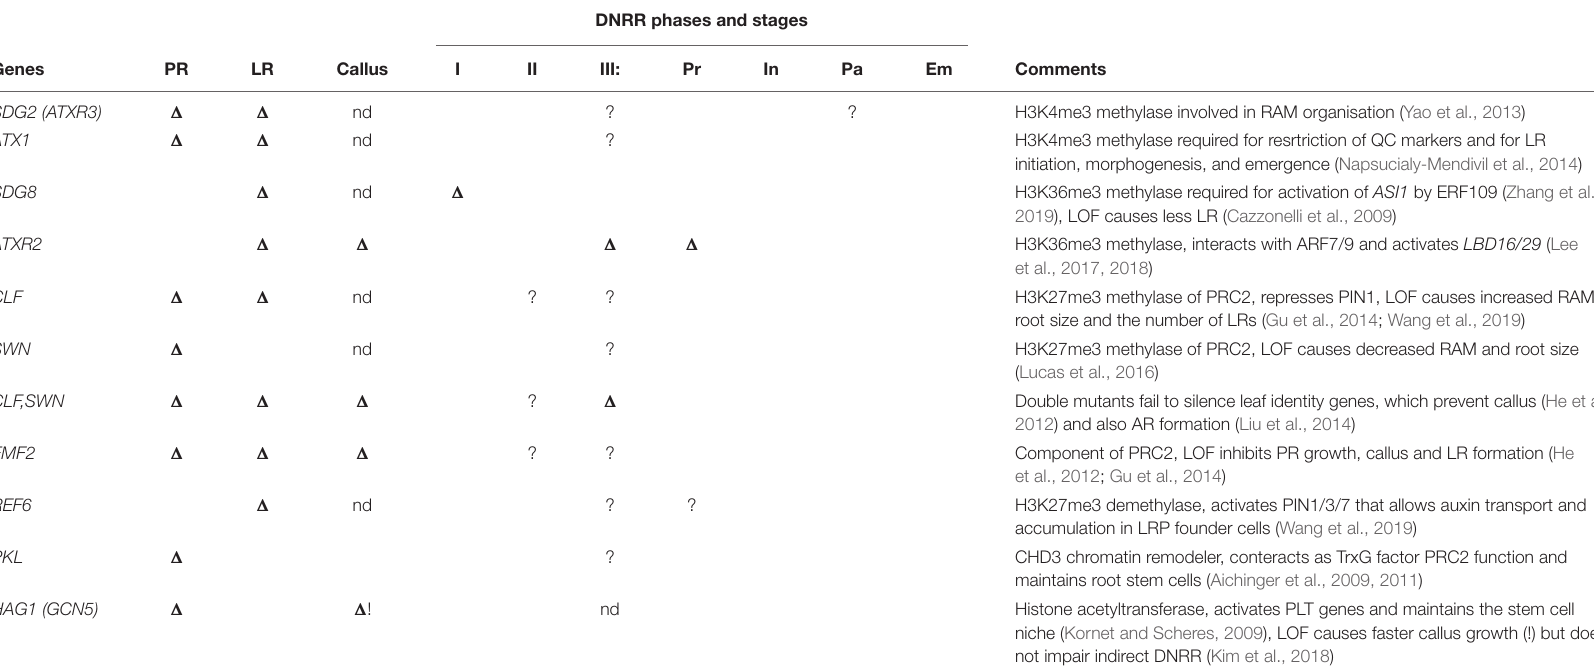
not impair indirect DNRR (Kim et al.,